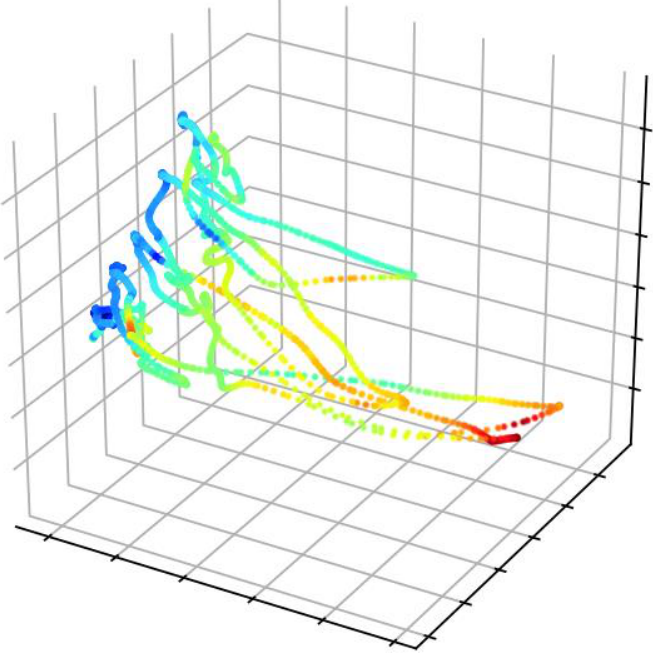
Figure 5. Visual feedback of the surgeon’s surgical task using CAM [50]. Visual feedback for the surgeon’s surgical task using CAM [50]. The red and orange subsequences in the plot show the high contribution to the surgeon’s surgical skill assessment task. In contrast, the green and blue subsequences indicate the low contribution.